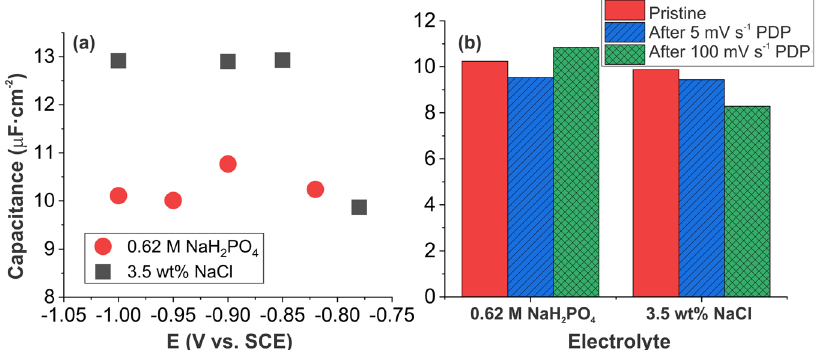
Fig. 3 The capacitance of AA7075 measured by electrochemical impedance spectroscopy (EIS). The capacitance of AA7075 extracted by the Brug equation as a function of ( a ) applied potential and ( b ) sample conditioning (measurements performed at OCP). The error bars represent a 95% con fi dence interval. Each measurement was done on a fresh